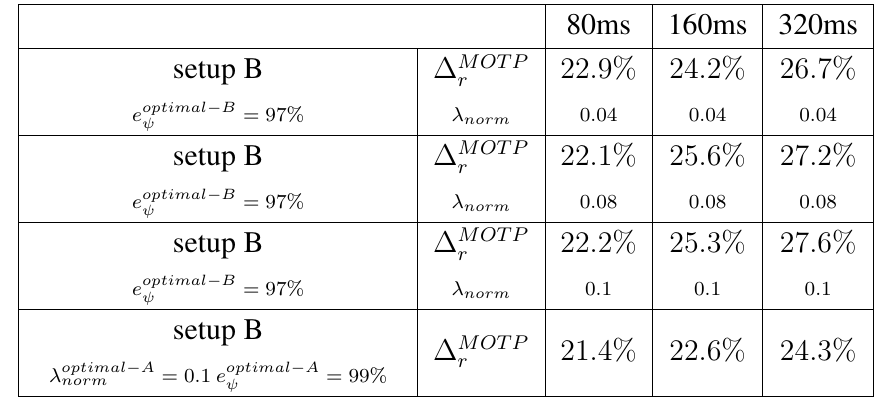
Table 5. Relative improvements of MOT P ( m ) for sequence seq01 and microphone setup B, using different values for the optimization